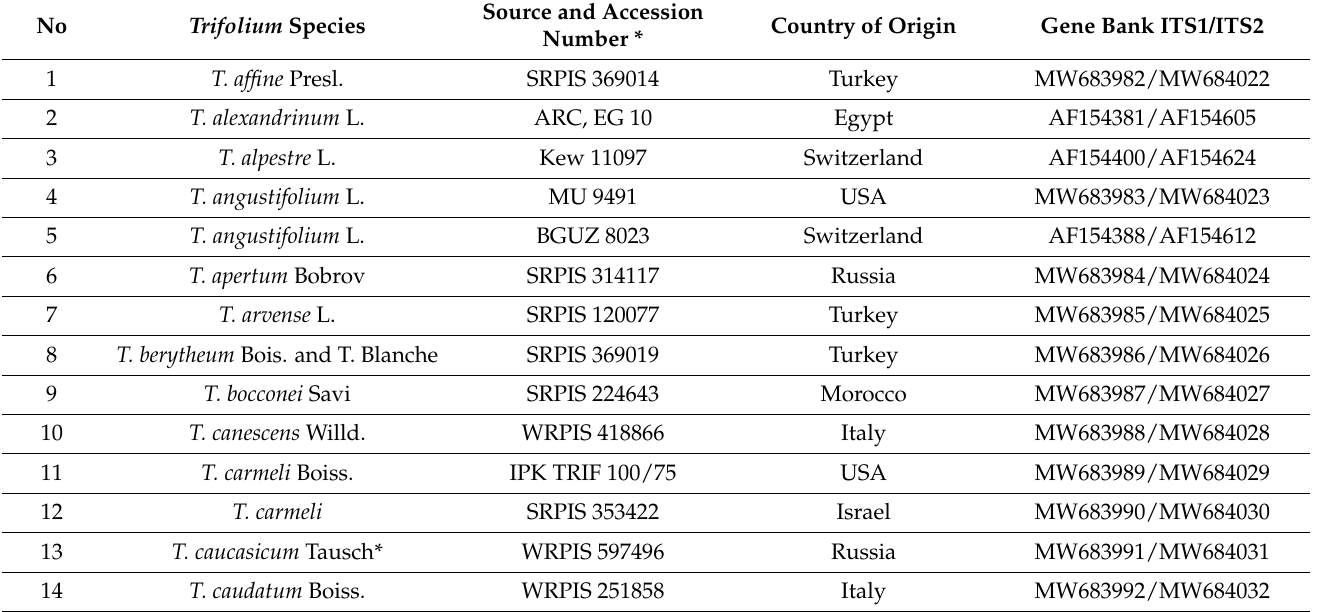
Table 2. Trifolium species names, source and accession number * , country of origin and Gene Bank submission number for ITS1/ITS2